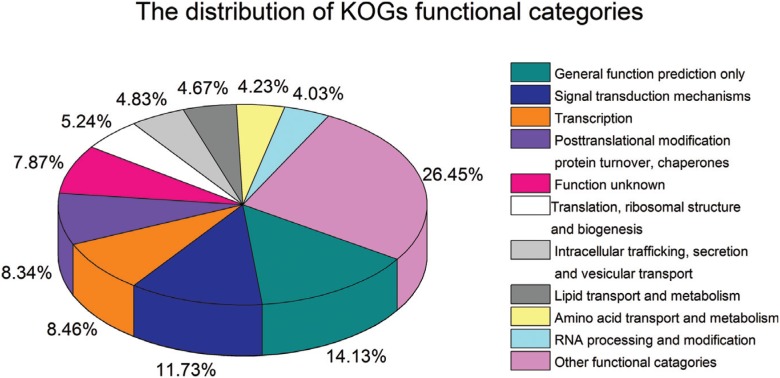
Clusters of orthologous group (KOG) classification.